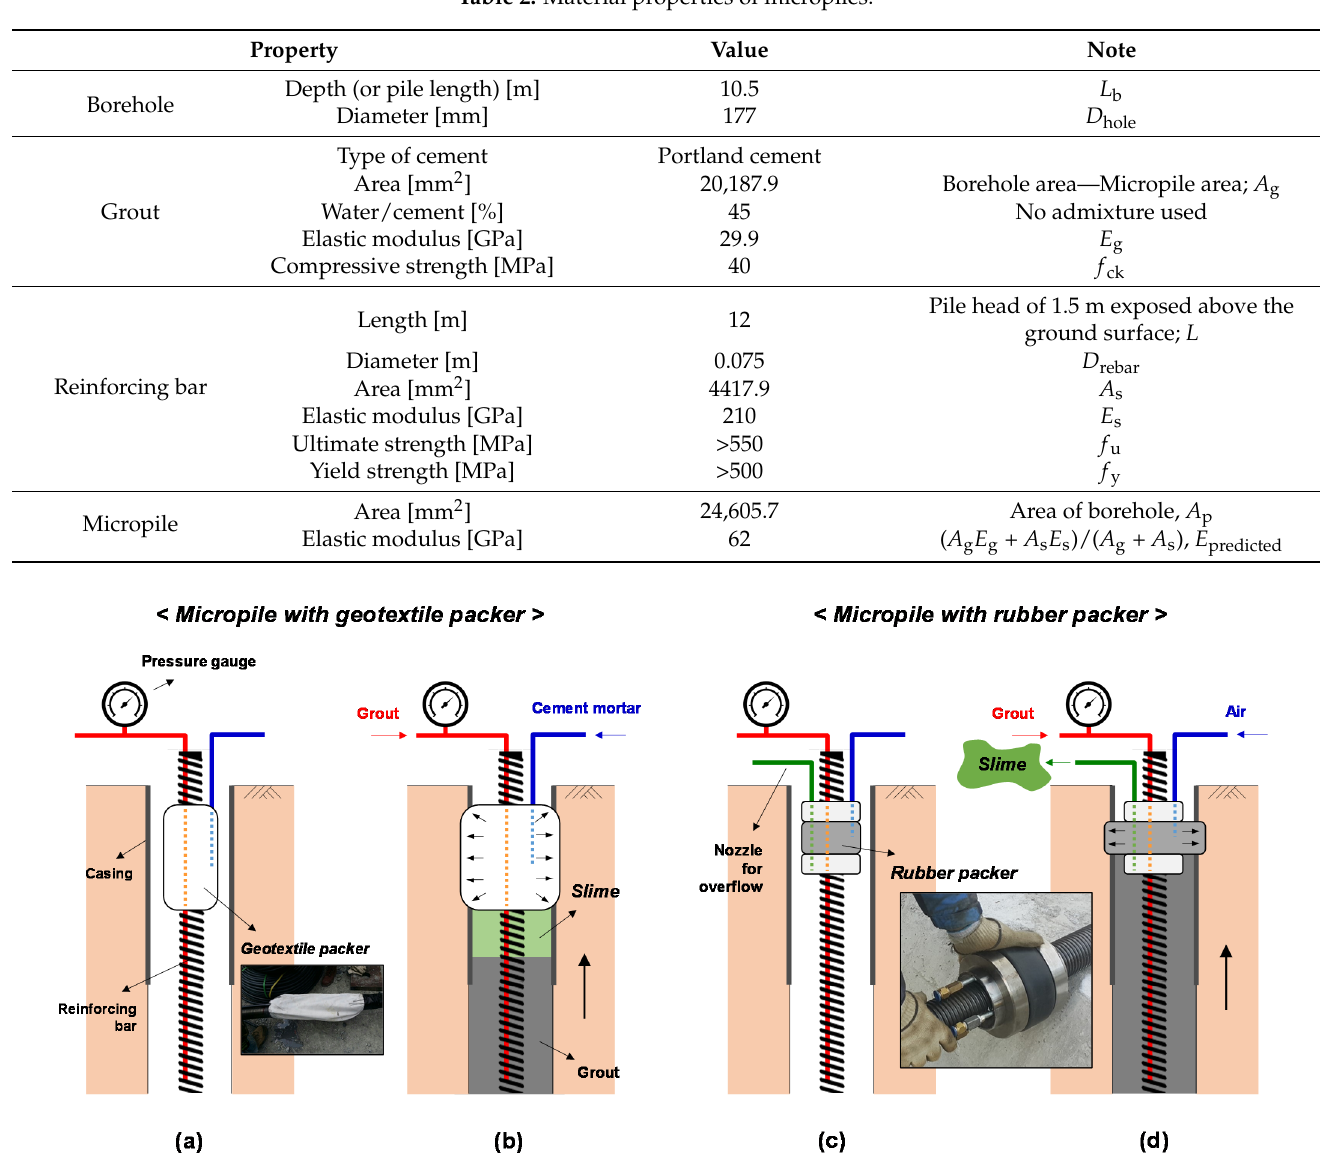
Figure 3. Construction processes of pressure-grouted micropiles using ( a , b ) geotextile and ( c , d ) rubber packers. ( a ) A reinforcing bar is placed into the borehole with a geotextile packer attached. ( b ) The geotextile packer is expanded by cement mortar; therefore, the borehole is packed. During grouting, slime is generated and transferred to the upper part of the borehole. ( c ) A reinforcing bar is placed in the borehole with a rubber packer attached. ( d ) The rubber packer is expanded using air and the borehole is filled with pure grout. In this case, slime can be discharged through a nozzle attached to the rubber packer. After the completion of grouting, the rubber packer is deflated and the packer is removed from the reinforcing bar for